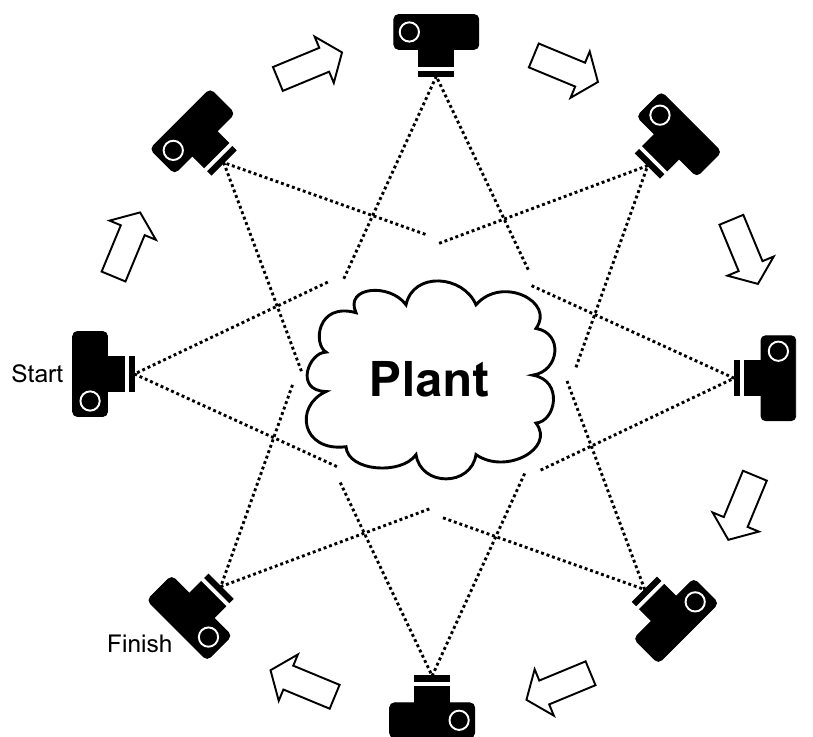
Figure 7. Illustration of structure-from-motion